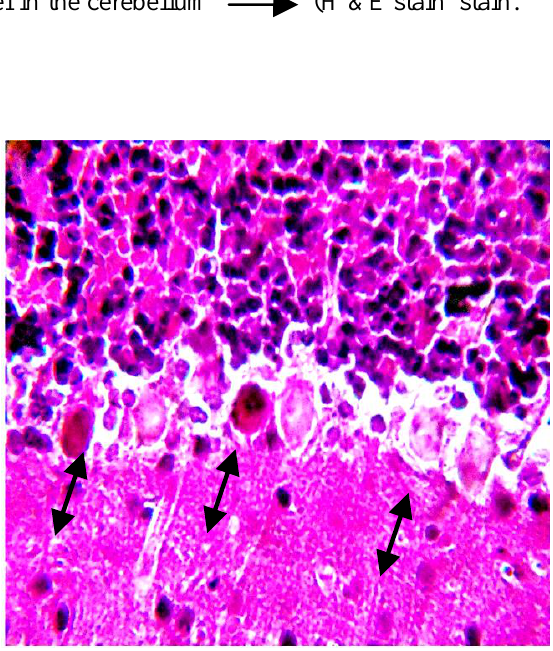
Fig:13, Histopathological section in Brain, T2,show Fig:14 Histopathological section in Brain, T2, focal astrocytes aggregation around congestion B.V show central chromatolysis with severe neurons (H& E stain. 40 X) degeneration, eosinophilc cytoplasm rounded border, loss of a centrical nuclei with lost of Nissle granules (H & E stain. 40